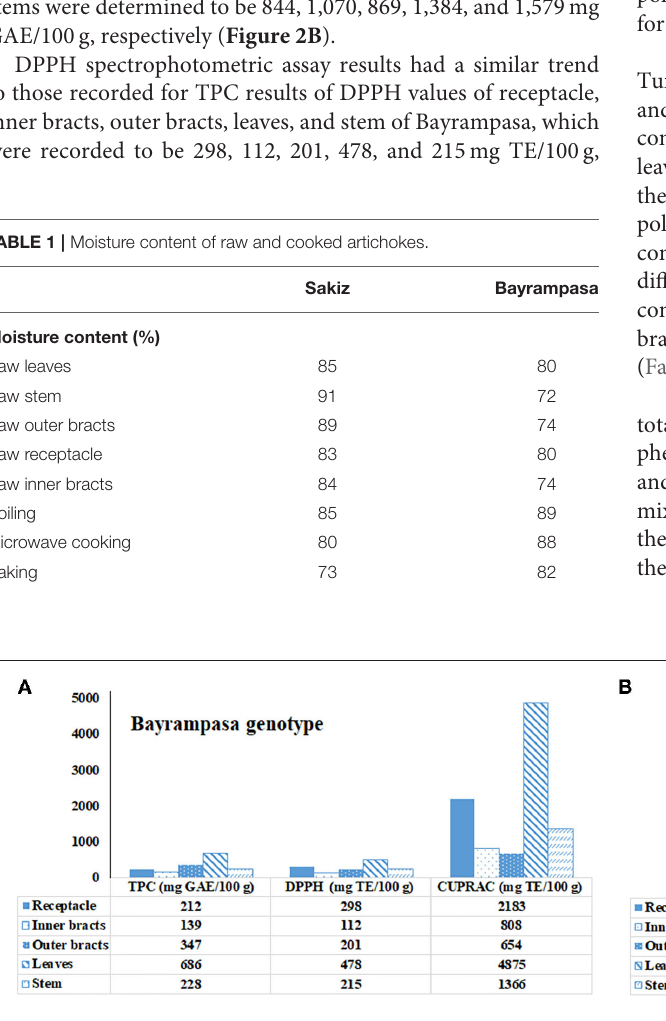
FIGURE 2 | TPC, DPPH, and CUPRAC values of different parts of raw Turkish artichokes ( A : Bayrampasa genotype and B : Sakiz genotype)